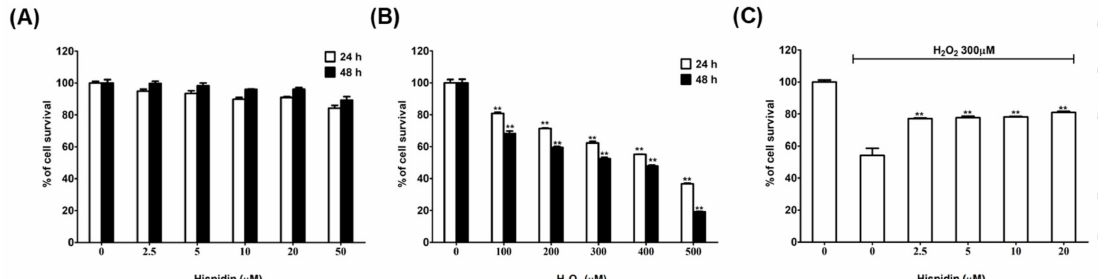
Figure 1. E ff ects of hispidin and H 2 O 2 on the viability of Adult Retinal Pigment Epithelial cell line-19 (ARPE-19) cells. ( A ) ARPE-19 cells were treated with various concentrations (2.5–50 µ M) of hispidin or ( B ) H 2 O 2 (100–500 µ M) for 24 ( (cid:3) ) and 48 h ( (cid:4) ), respectively. Cell survival was measured by MTT assay ( C ) ARPE-19 cells were pre-treated with hispidin (0–20 µ M) for 24 h, followed by 300 µ M H 2 O 2